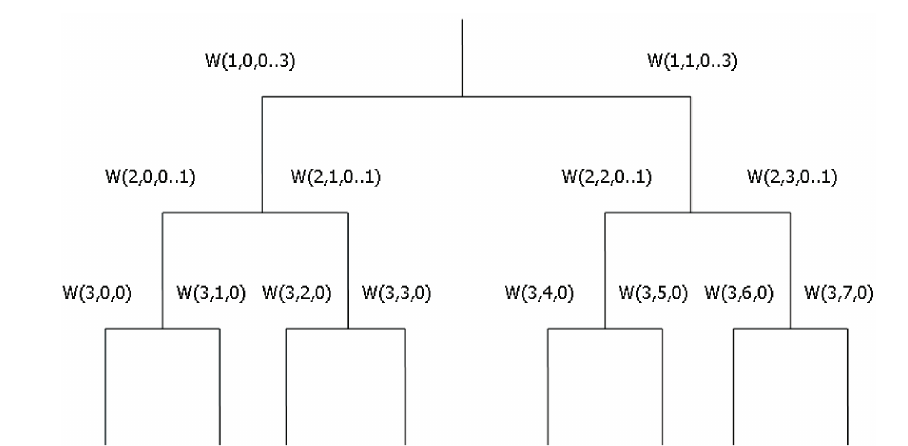
Figure 4. A set of Haar functions.